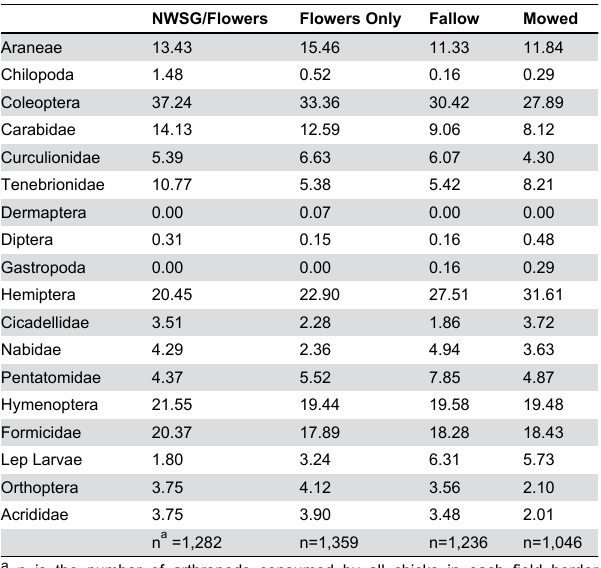
Table 1. Percentage of arthropods consumed by northern bobwhite chicks in four field border treatments by taxonomic order and most frequently consumed taxonomic family (June to August 2009 and